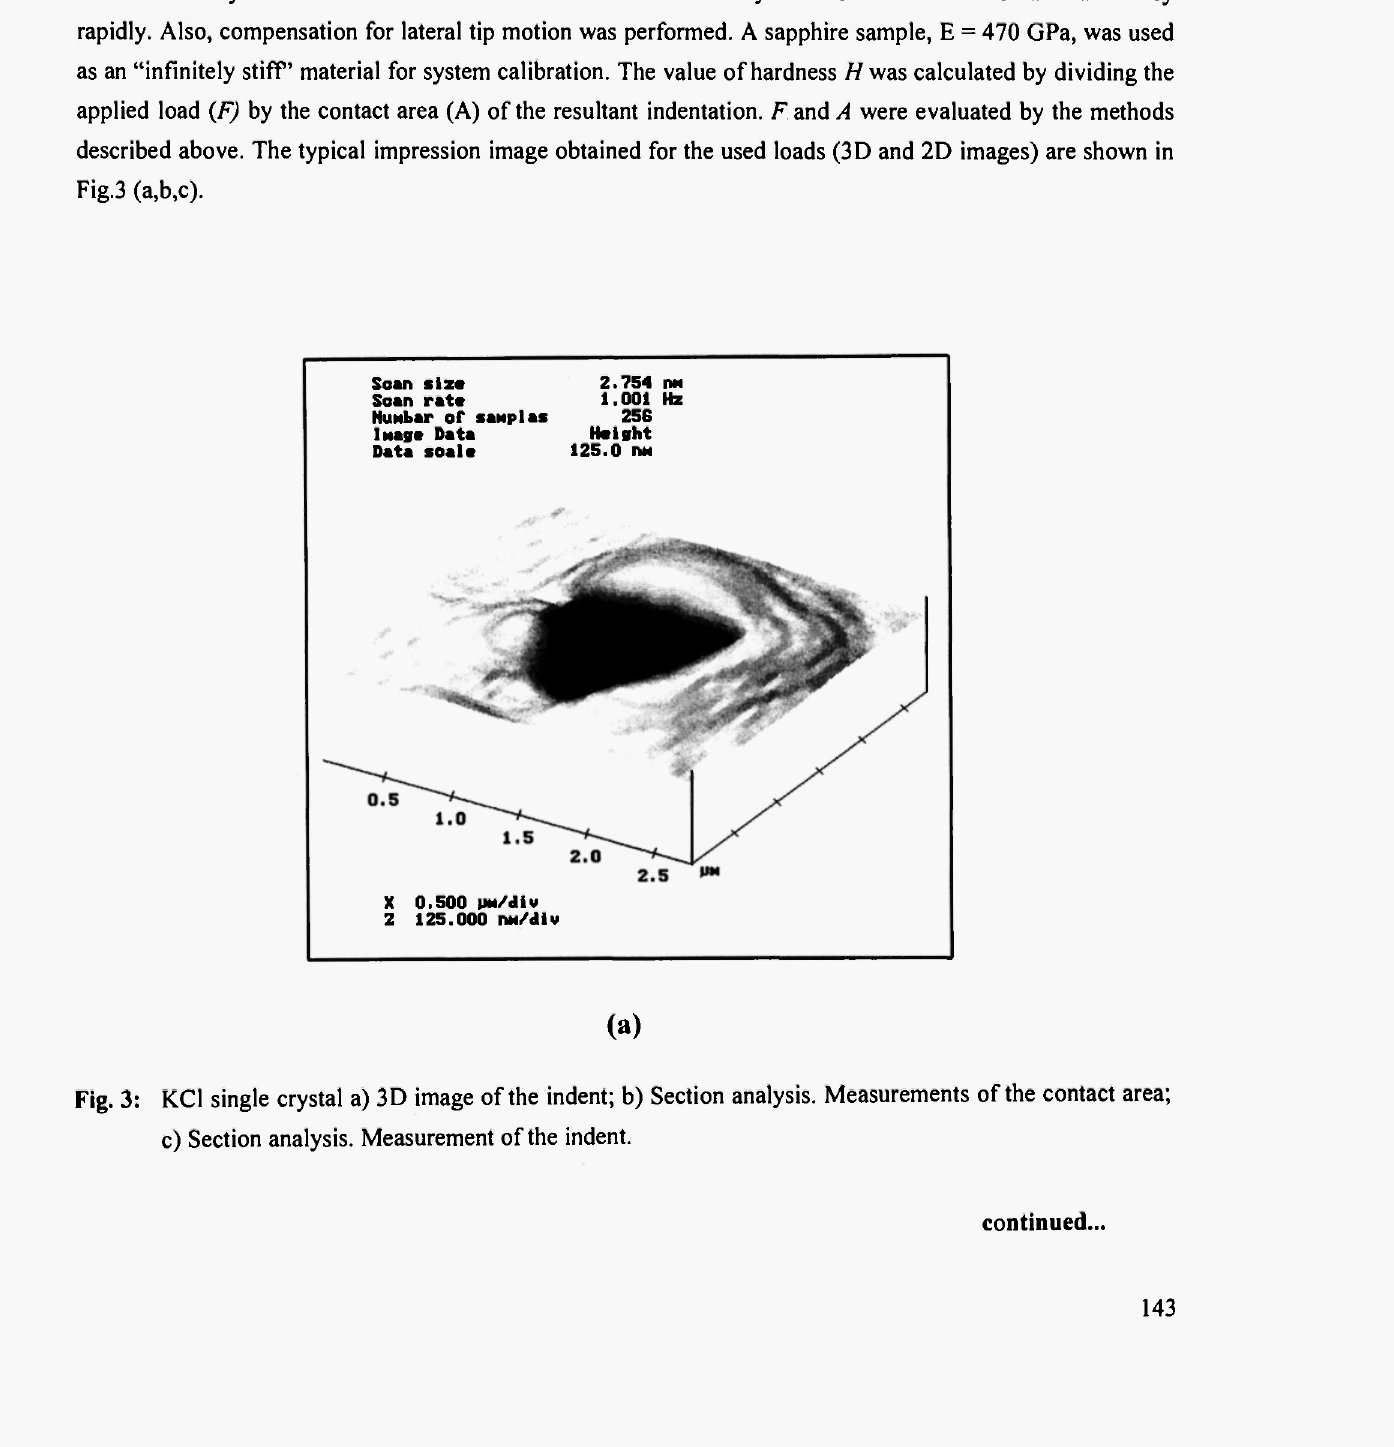
KCl single crystal a) 3D image of the indent; b) Section analysis. Measurements of the contact area; c) Section analysis. Measurement of the